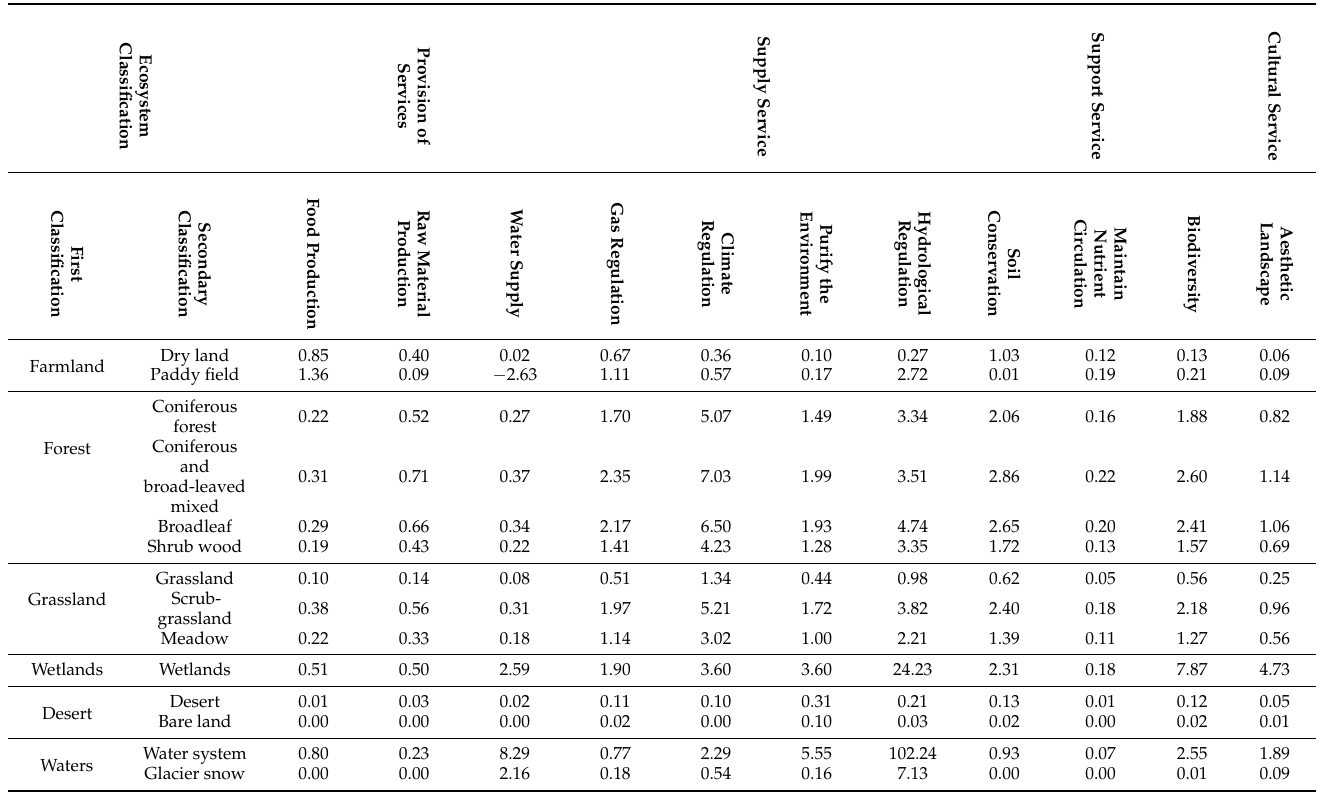
Table A3. Ecosystem service equivalent value per unit area in China’s terrestrial ecosystem (2015).